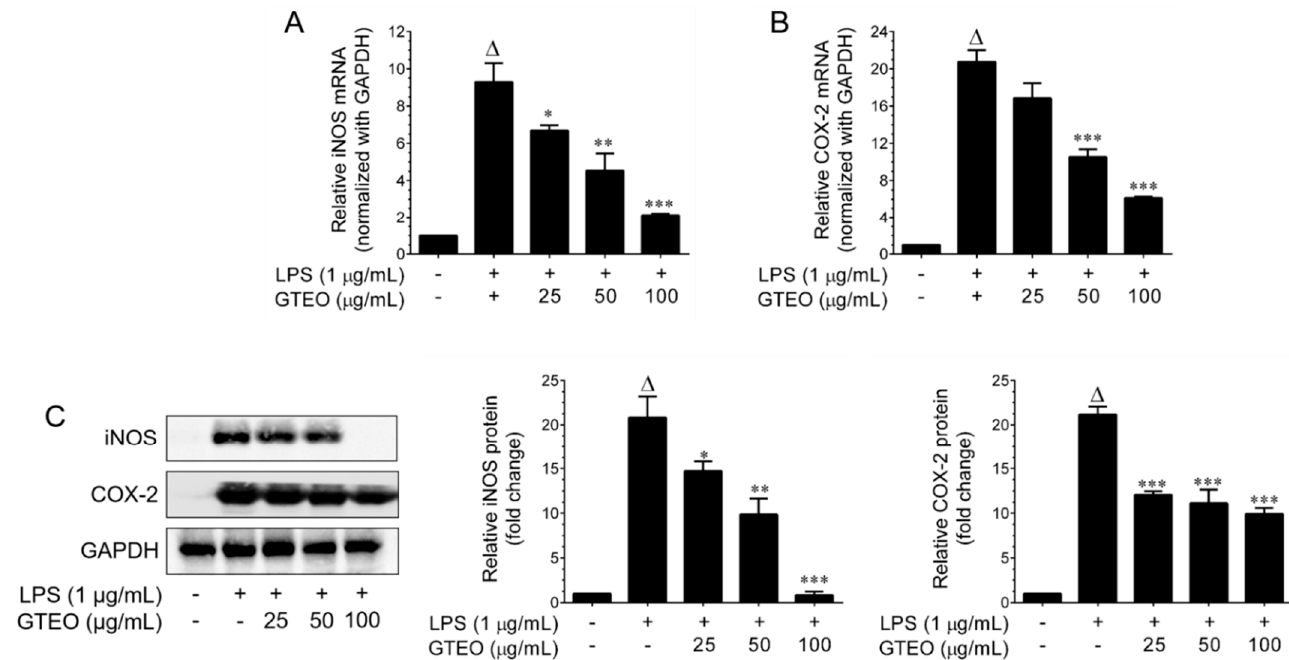
Figure 2. Effect of GTEO on LPS-induced iNOS and COX-2 expression. ( A , B ) RAW 264.7 cells were stimulated with LPS (1 μ g/mL) and incubated in the presence or absence of increasing concentrations (25–200 μ g/mL) of GTEO for 6 h. Total RNA was extracted and the transcription levels of iNOS and COX-2 were quantified by Q-PCR. The Δ ct values of iNOS and COX-2 mRNAs were normalized with GAPDH mRNA. ( C ) RAW 264.7 cells were co-incubated with various doses of GTEO (25, 50, and 100 μ g/mL) and 1 μ g/mL LPS for 24 h. Protein expression levels of iNOS and COX-2 were determined by immunoblotting with specific antibodies. GAPDH served as an internal loading control. Histogram shows the relative protein expression levels of iNOS and COX-2, which are normalized with an internal control GAPDH. Data are reported as mean ± SD of three independent experiments. Δ p < 0.001 indicates a significant difference between the control and LPS-only treated groups. * p < 0.05, ** p < 0.01, and *** p < 0.001 show significant differences between the LPS-alone and GTEO treatment group.